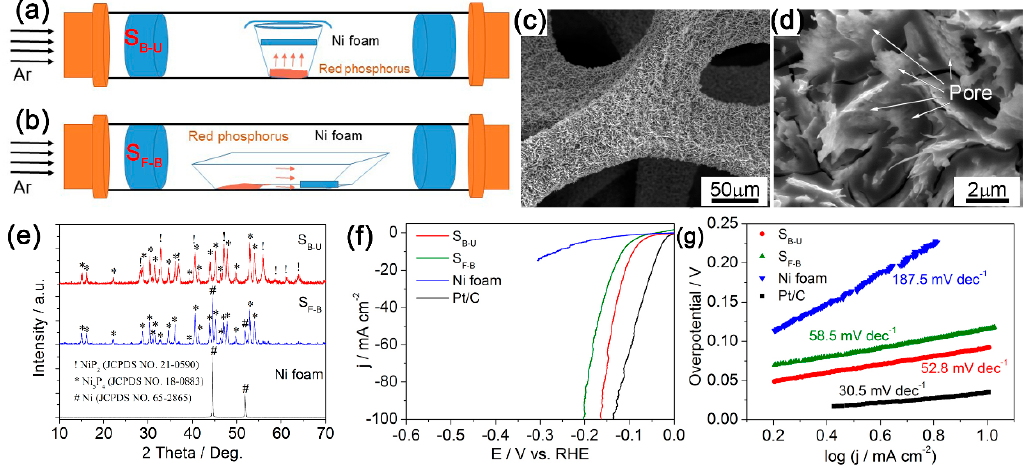
Figure 9. Schematic illustration for preparation of nickel phosphide by the method with bottom-up placement S B-U ( a ) and an upstream-downstream placement S F-U ( b ). Low- ( c ) and high- ( d ) magnification SEM images of S B-U . XRD patterns of the S B-U (500 °C), S F-B (500 °C), and the pristine Ni foam ( e ). Polarization curves ( f ) and Tafel plots ( g ) of the S B-U (500 °C), S F-B (500 °C), pristine Ni foam, and Pt/C catalyst. Reproduced with permission from Reference [117], Copyright Elsevier B.V., 2019.